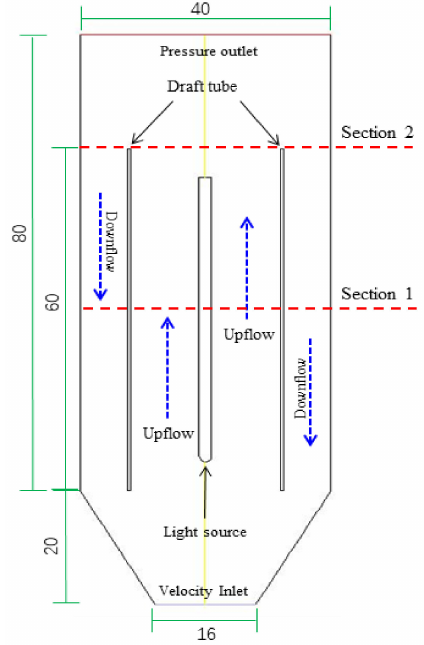
Figure 1. Schematic diagram of the internal airlift circulating photoreactor for the simulation